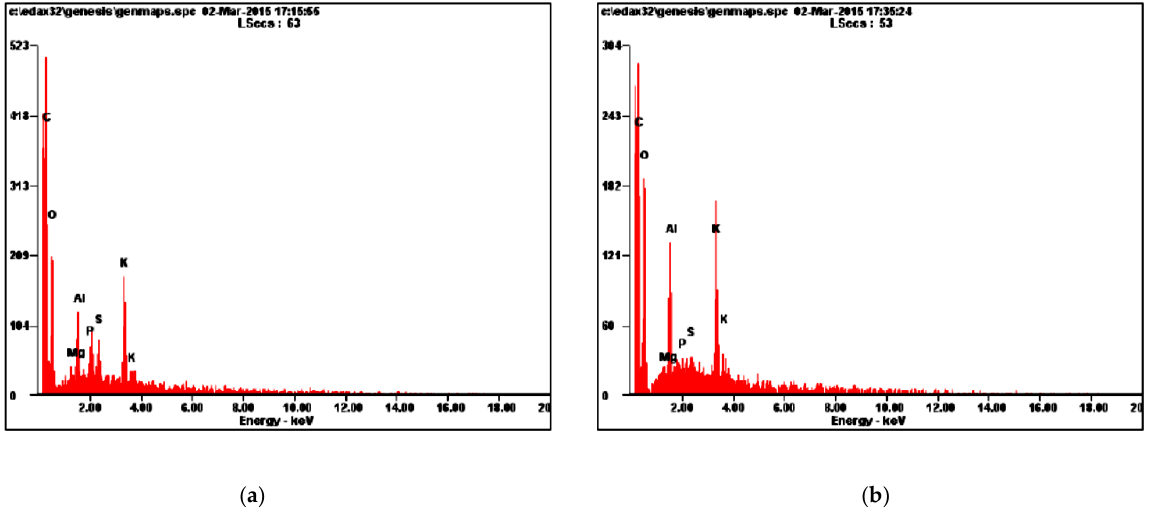
Figure 1. EDX spectra recorded for soybean biomass ( a ) and soybean waste biomass ( b ). The nature of the functional groups on the surface of these biosorbents and the differences that appear in the structure of the soybean biomass after the extraction stage were highlighted with the help of IR spectrometry. A detailed analysis of the IR spectra recorded on the dry matter (Figure 2) showed that, in the soybean biomass spectrum (spectrum 1), the most important absorption bands correspond to the functional groups of proteins and polysaccharides in the cell walls. Thus, the absorption band at 3407 cm − 1 (which corresponds to the stretching vibration of the O–H bond from aliphatic alcohols and water molecules), the bands at 1652 and 1543 cm − 1 (attributed to the stretching vibration of the C=O bond of carbonyl compounds), the bands of 1244 and 1053 cm − 1 (corresponding to the symmetrical and asymmetric tensile vibration of the P=O bond in the phosphate groups), and the bands between 1200 and 690 cm −1 (which can be attributed to the vibra- tions of the C – OH bonds and C – O – C in polysaccharides) [45] indicate the presence of functional groups, such as hydroxyl, carbonyl, carboxyl, phosphate groups, etc., which may play an important role in the retention processes of the studied metal ions. After the extraction stage, in the IR spectrum of soybean waste (Figure 2, spectrum 2), most of the absorption bands are slightly shifted towards higher wave numbers (2 – 3 cm −1 ), while the absorption bands at 2858 cm −1 , 1741 cm −1 , 1402 cm −1 and 1244 cm −1 , which are characteristic of lipids, have disappeared or decreased in intensity (without changing too much the position of the maximum absorption). These differences show that, at the extraction stage, only this type of component (lipids) was removed from the soybean bio- mass composition, while most proteins and polysaccharides remained in the soybean bi- omass composition, and their functional groups will be binding centers for metal ions in the aqueous solution.